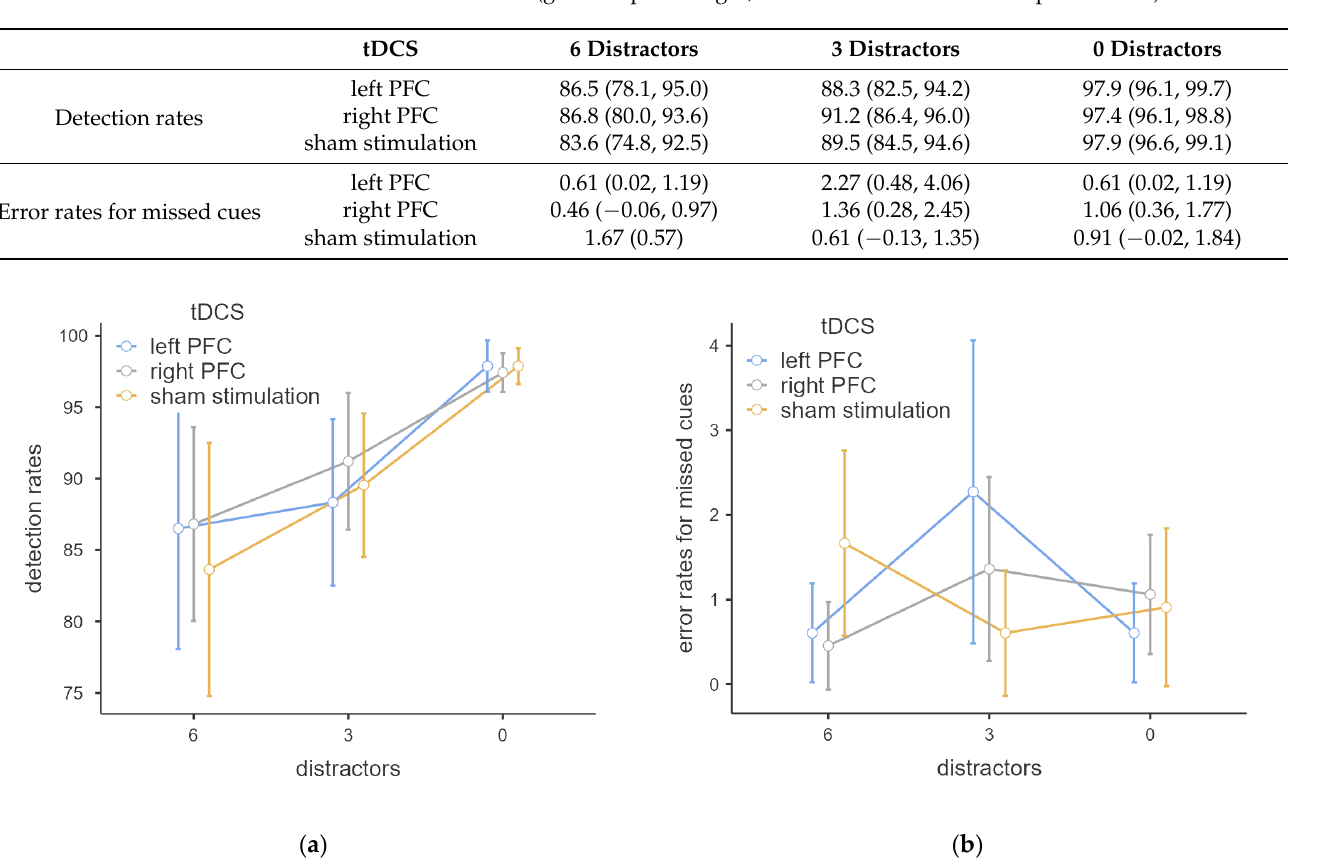
Figure 1. Detection and error rates for missed cues (given as percentages), error bars indicate 95% confidence intervals. ( a ) Detection rates depending on number of distractors and stimulation condition; ( b ) error rates for missed cues depending on number of distractors and stimulation condition. Table 1. Detection rates and error rates for missed cues depending on number of distractors and stimulation conditions (given as percentages, 95% confidence intervals in parentheses).